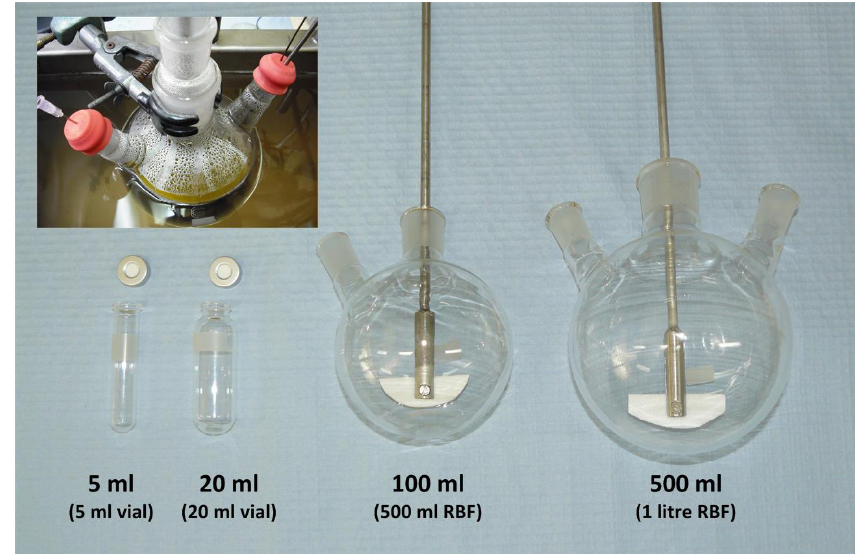
Figure 1. Photo of batch glass reaction vessels for 5 mL, 20 mL, 100 mL and 500 mL reaction scale; the insert on the top left shows an image taken during the 500 mL